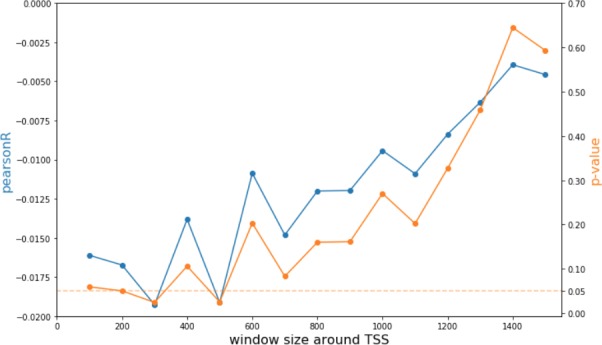
Analysis of CpG modification changes in promoters of differentially expressed genes.Pearson correlations and p-values of comparisons between promoter CpG modifications and fold change of corresponding genes as a function of window size around each promoter.